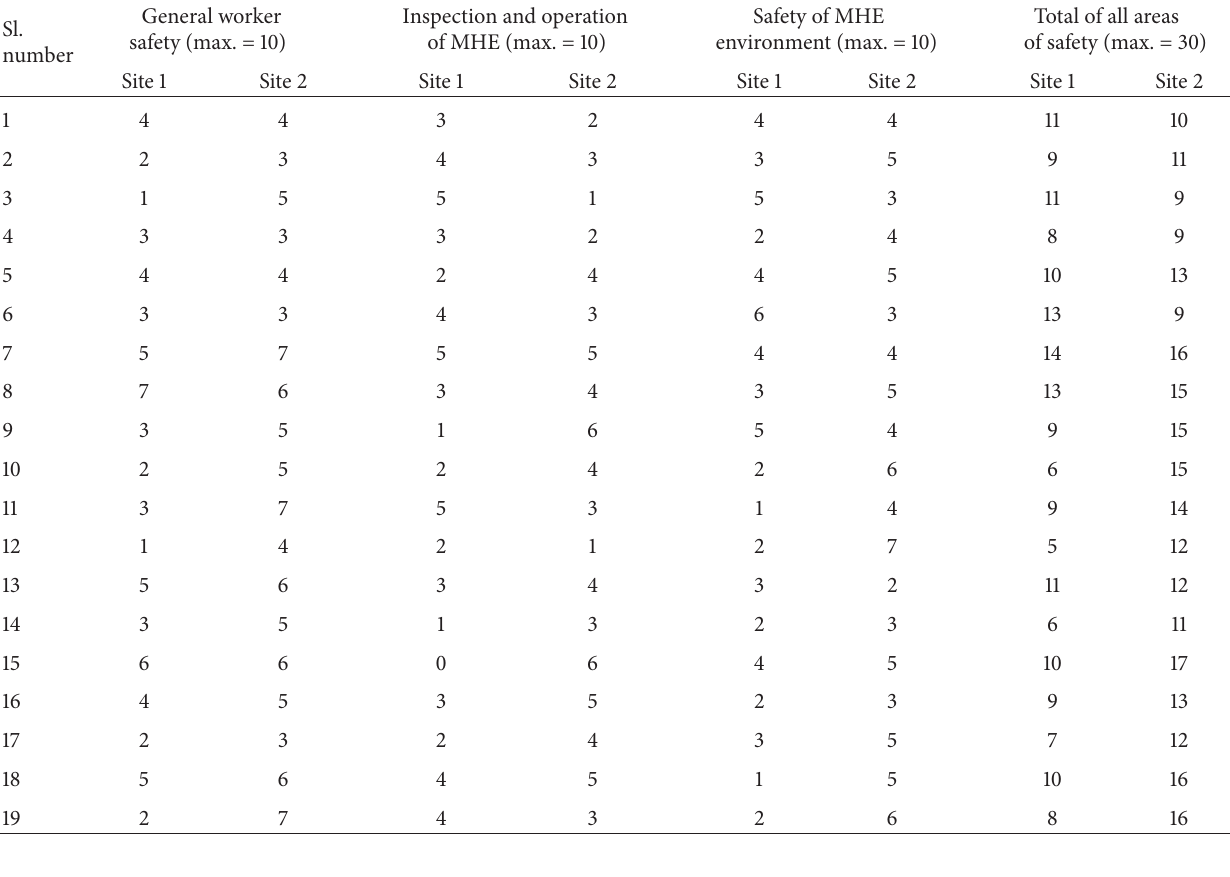
Table 6: Results analysis of the safety education program.